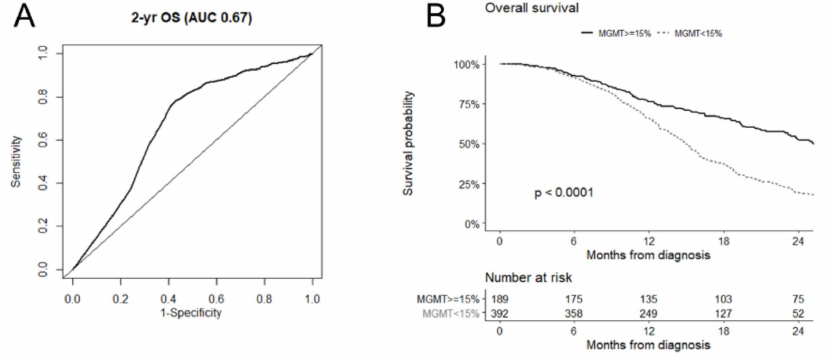
Figure 3. Receiver operating characteristics (ROC) curve of MGMT promoter methylation for 2-year overall survival (OS) in glioblastoma patients ( A ); overall survival for patients with MGMT methyla- tion ≥ 15% and those with MGMT <15%, according to the cut-off suggested by ROC curve analysis ( B